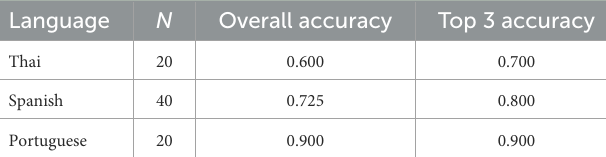
TABLE 2 Multi-linguicism assessment for DR-COVID showing the top 3 performing non-English